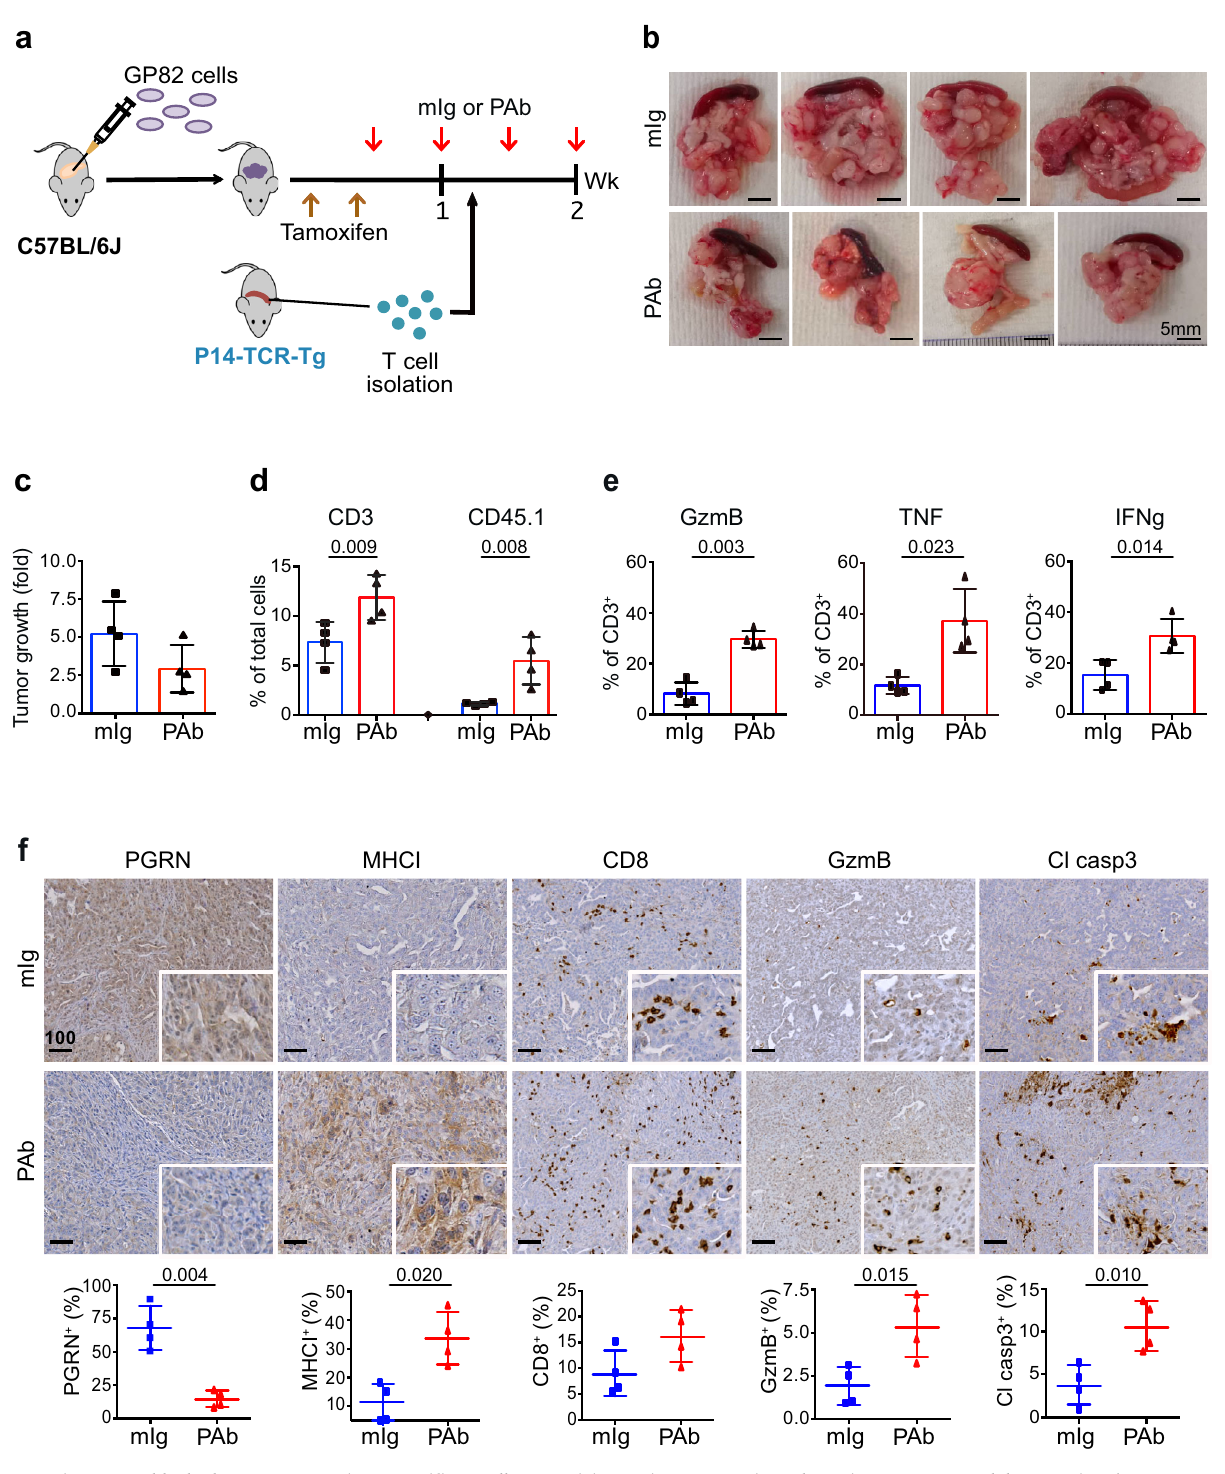
Fig. 8 In vivo PGRN blockade promotes antigen-speci fi c T-cell cytotoxicity against tumors in orthotopic FKPC2GP model. a Timeline for treatment of anti-PGRN antibody (PAb) or mIg (50 mg/kg) in an orthotopic model of GP82 cells in C57BL/6 J mice. b Tumors and spleens of mIg-treated ( n = 4) and PGRN Ab-treated ( n = 4) mice with orthotopic GP82 transplantation and intravenous injection of LCMV-gp33-reactive T cells freshly isolated from P14- TCR-Tg mice. c Tumor growth was assessed by ultrasound imaging and presented as a fold change in tumor volume before and after PGRN Ab (PAb) or mIg treatment started. d Tumors were digested into disaggregated cells and stained for T-cell in fi ltration. Flow cytometric analysis showing the percentage of tumor-in fi ltrating T (CD3 + ) cells and the exogenously injected LCMV-gp33-reactive (CD45.1 + ) T cells, in tumors treated with PGRN Ab ( n = 4) or mIg ( n = 4). Two-tailed Mann – Whitney test. e Flow cytometric analysis showing the expression of cytotoxic markers granzyme B (GzmB), TNF, and IFNg on CD3 + T cells in tumors with PGRN Ab ( n = 4) or mIg ( n = 4). Two-tailed Mann – Whitney test. f IHC staining of PGRN, MHCI marker H-2Db, CD8,